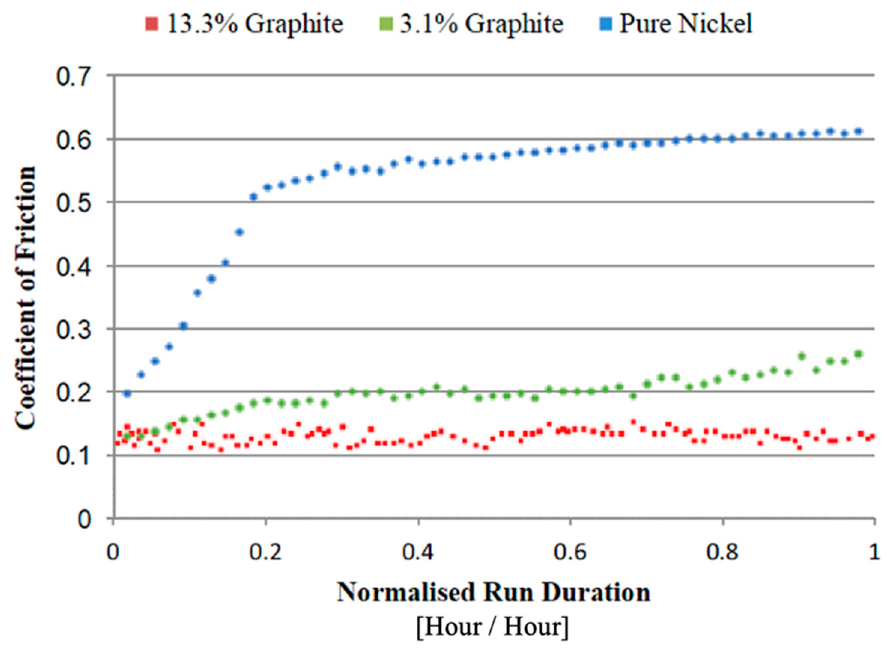
Figure 11. Representative data sets for the evolution of CoF versus time for the three coating compositions tested.